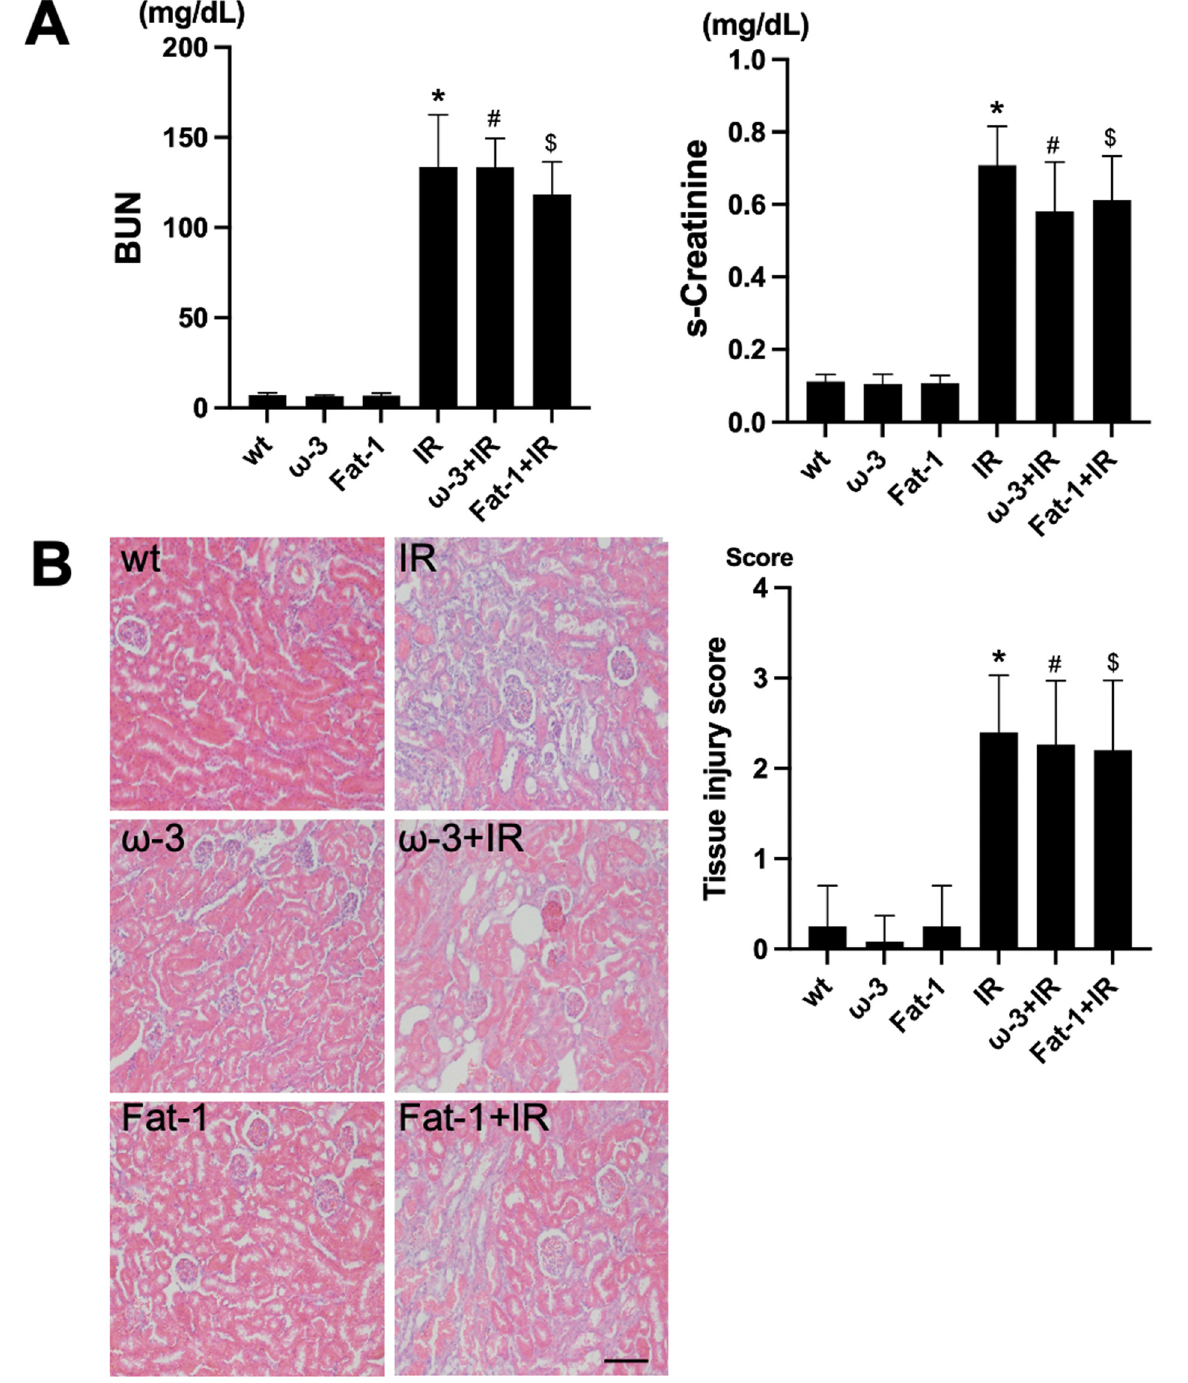
Figure 1. Renal function and histology in ischemia-reperfusion (IR) kidney. ( A ) The levels of blood urea nitrogen (BUN) and serum creatinine (s-Cr) were significantly increased in IR mice compared to wt mice. ω -3+IR mice also had higher BUN and s-Cr levels as compared to ω -3 mice, and Fat-1+IR mice also had higher BUN and s-Cr levels as compared to Fat-1 mice. ( B ) Representative kidney section with H&E stain; renal injury tissue represents cell debris, tubular necrosis, and inflammatory cells. Original magnification, 200 × . Scale bar = 50 µ m. * p < 0.001 vs. wt, # p < 0.001 vs. ω -3, $ p < 0.001 vs. Fat-1. The bar represents mean ± S.D. (wt, wild-type sham; ω -3, ω -3 PUFA oral administration sham; Fat-1, Fat-1 induction sham; IR, IR renal injury in wild-type mice; ω -3+IR, IR renal injury in ω -3 PUFA oral administration mice; Fat-1+IR, IR renal injury in Fat-1 induction mice).